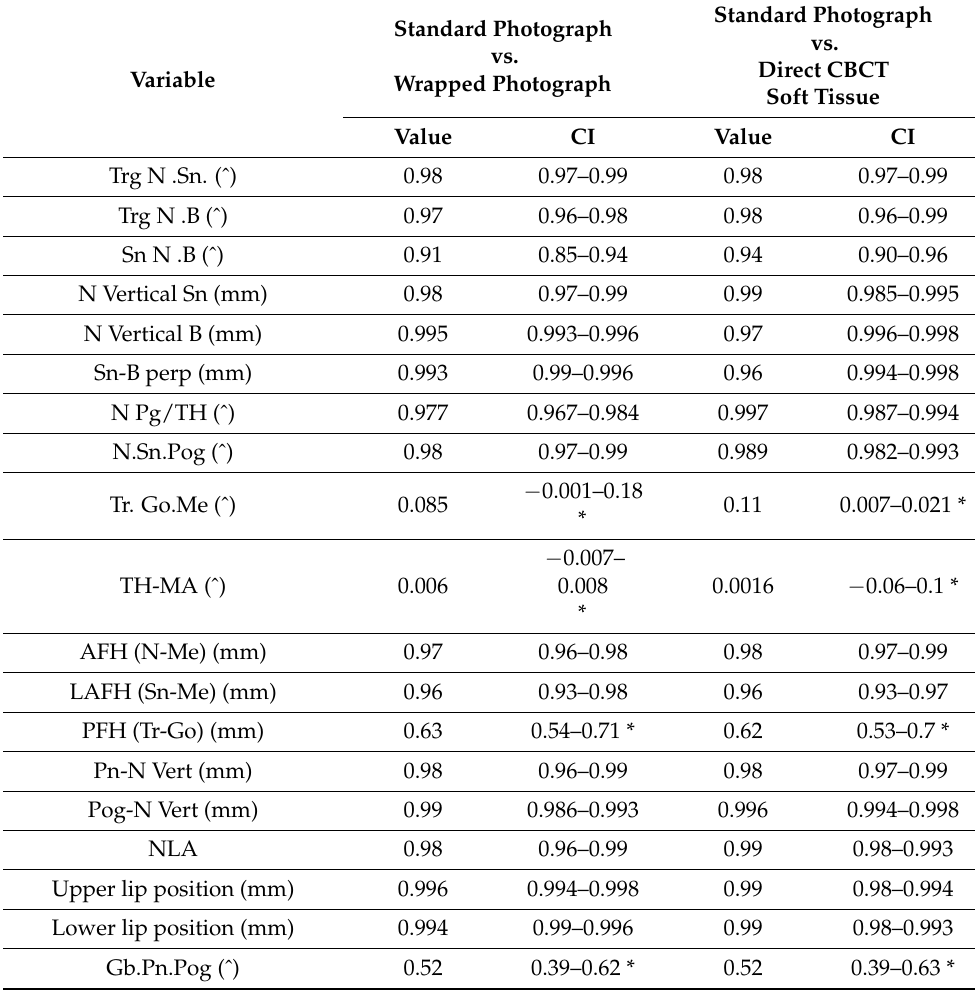
Table 3. The concordance correlation coefficients (CCC) reflecting the reliability of the measurements of the applied methods. Standard Standard Photograph vs. Variable Wrapped Photograph